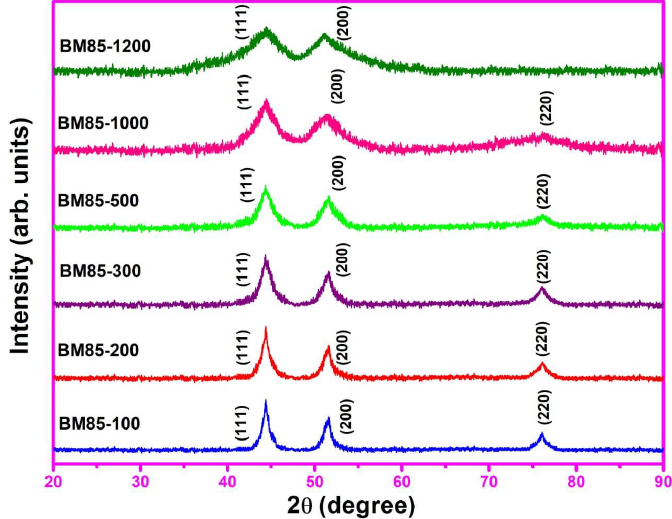
Figure 2. XRD patterns of Co 15 Ni 85 NPs milled at 1425 rpm for 100, 200, 300, 500, 1000 and 1200 min.